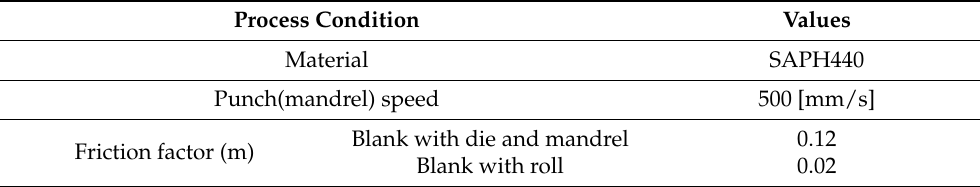
Table 2. The conditions for the finite element (FE) simulation.